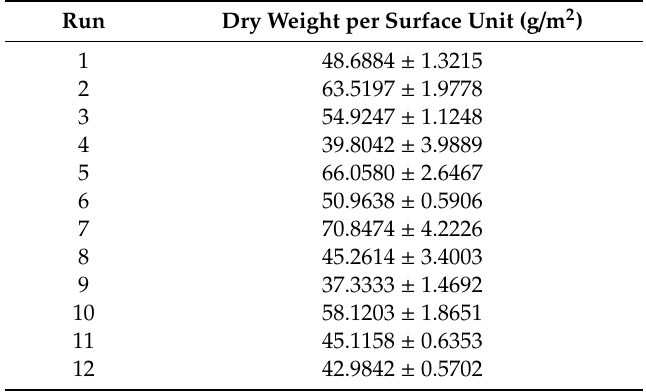
Table A1. Results of yield calculated as a dry weight per surface unit.